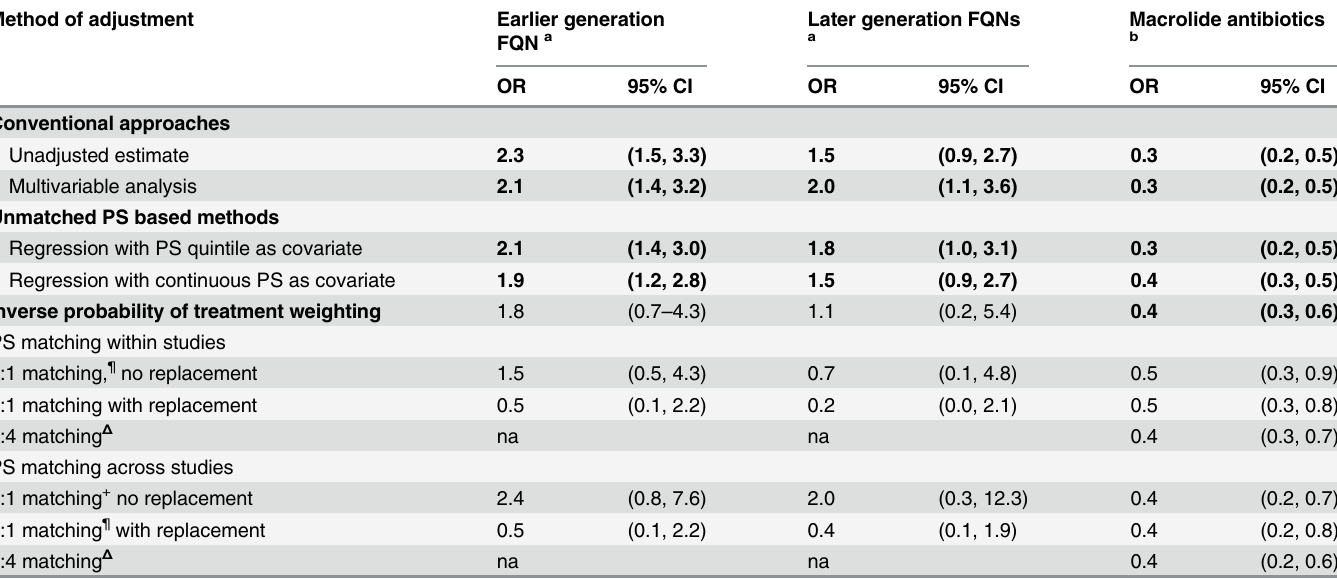
Table 8. The relationship between antibiotic use and successful treatment of tuberculosis (versus death or failure — excluding relapse and loss to follow-up) applying different analytic methods to account for